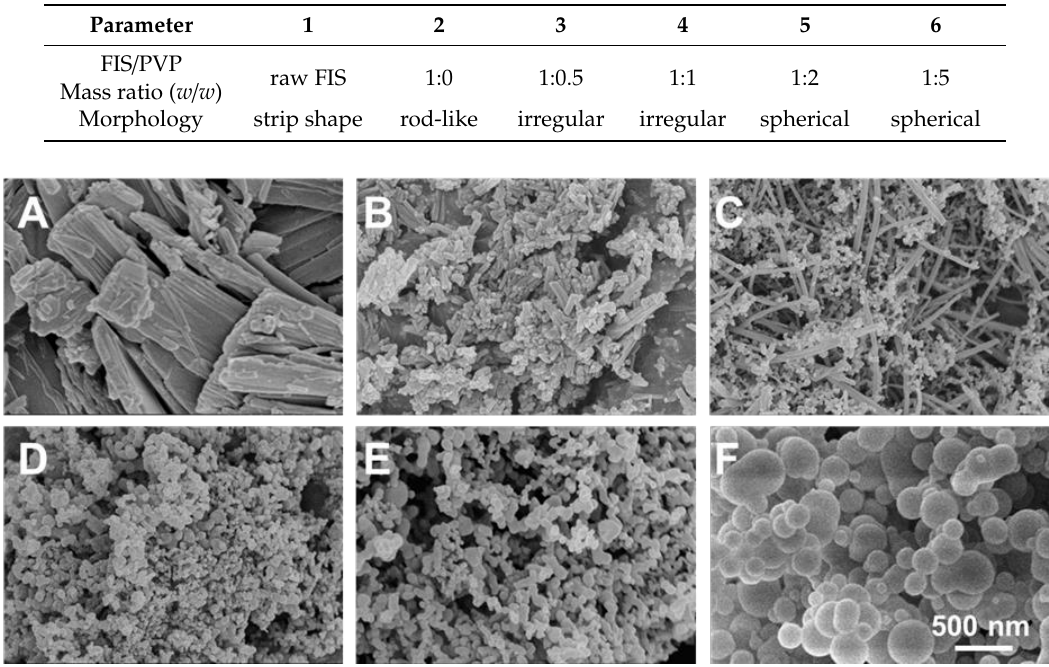
Table 1. Influence of experimental conditions (FIS/PVP mass ratio) on the morphology of the resultant products at a solution flow rate of 1 mL min − 1 .